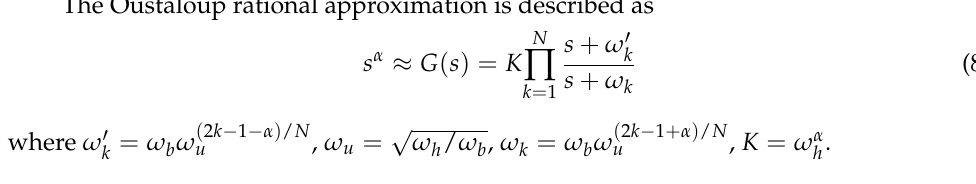
Table 1. Rule table with the Toeplitz structure.